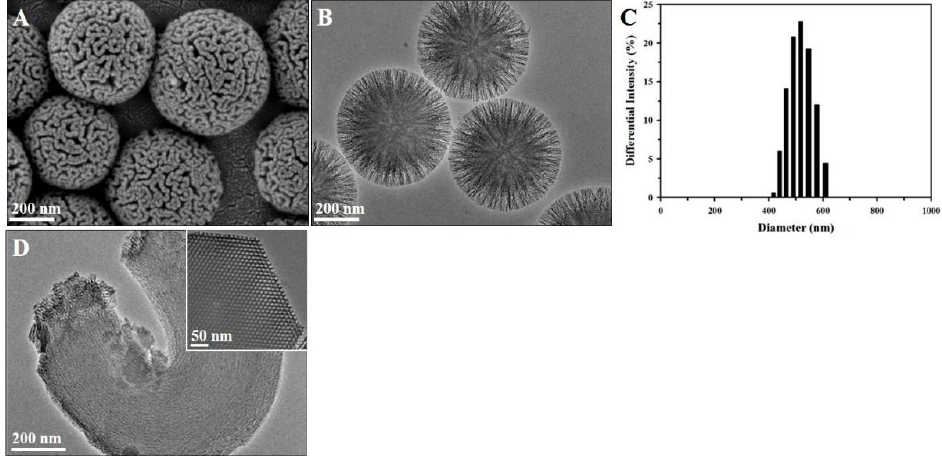
Figure 2. SEM images of the synthesized RMSNs ( A ); TEM images of the synthesized RMSNs ( B ); Size distribution histogram of RMSNs ( C ); and TEM images of the synthesized SBA-15 ( D ). The inserted TEM image shows the cross-section of an SBA-15.